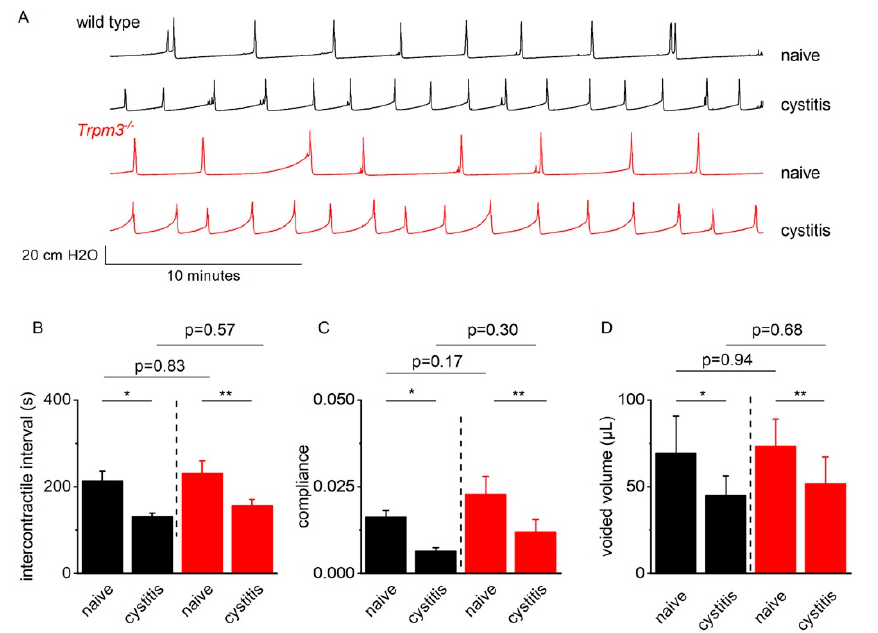
Figure 6. Cystometry in wild-type and Trpm3 − / − mice with CYP-induced cystitis. ( A ) Representative examples of cystometry in naive and cyclophosphamide (CYP) pretreated wild type (black) and Trpm3 − / − (red) mice. ( B – D ) Mean ( ± SE) intercontractile interval, bladder compliance, and voided volume during cystometry in naïve wild type ( n = 8, black) and Trpm3 − / − mice ( n = 7, red) and CYP-pretreated wild type ( n = 7, black) and Trpm3 − / − ( n = 8, red) mice. * p < 0.05; ** p < 0.01.